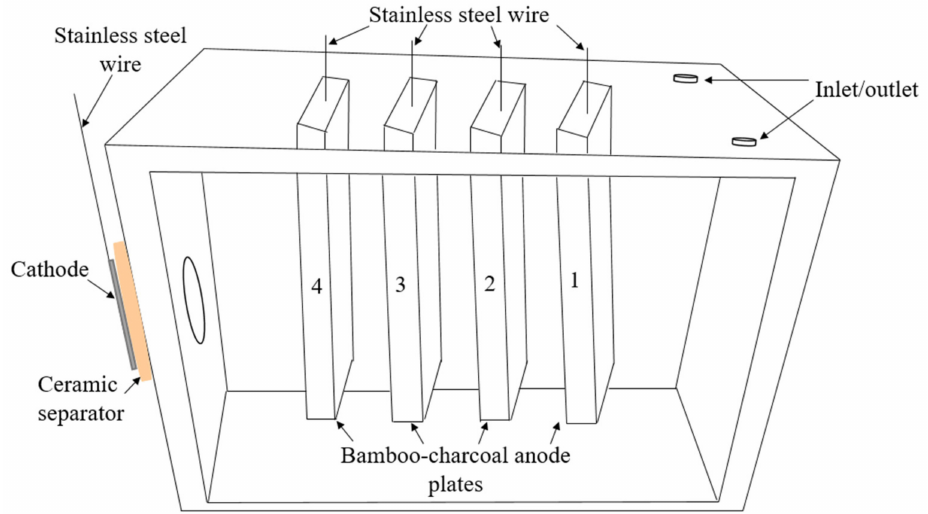
Figure 1. Representation of a single-chamber MFC with 4 bamboo-charcoal anode plates, ceramic separator, and platinum-coated carbon cloth